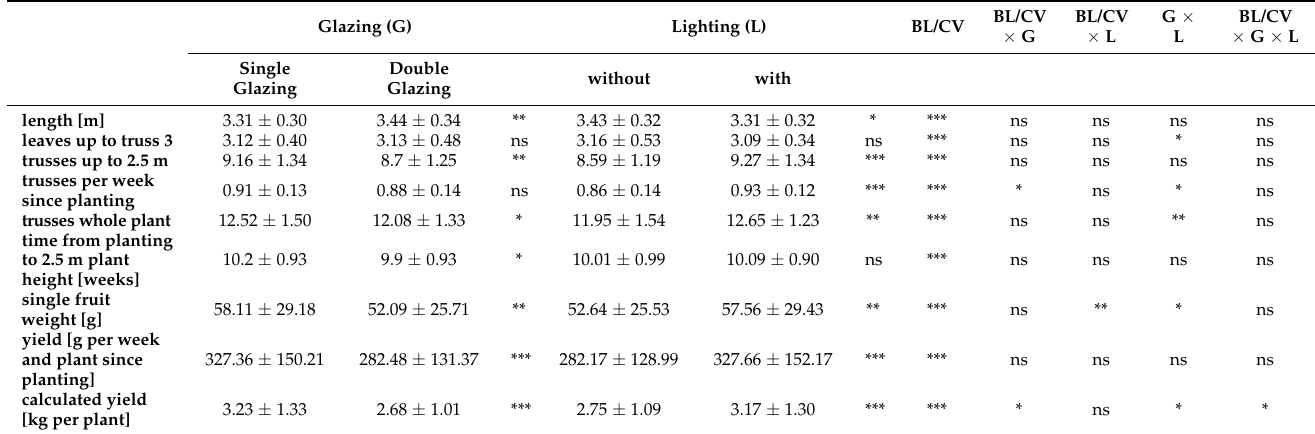
Figure 2. Fold changes (FC) of metabolites from fruits of CS 4 (double glazing greenhouse without LED) compared to fruits of CS 2 (single glazing greenhouse without LED) of two breeding lines (170, 157) and Lyterno F 1 (each n = 3) ( t -test p ≤ 0.05). Glucose and Fructose were analyzed with HPLC. Table 5. Mean values ± standard deviation of agronomic traits of the five breeding lines and Lyterno F 1 , distinguished between single-glazed and double-glazed greenhouses, or with and without supplementary LED